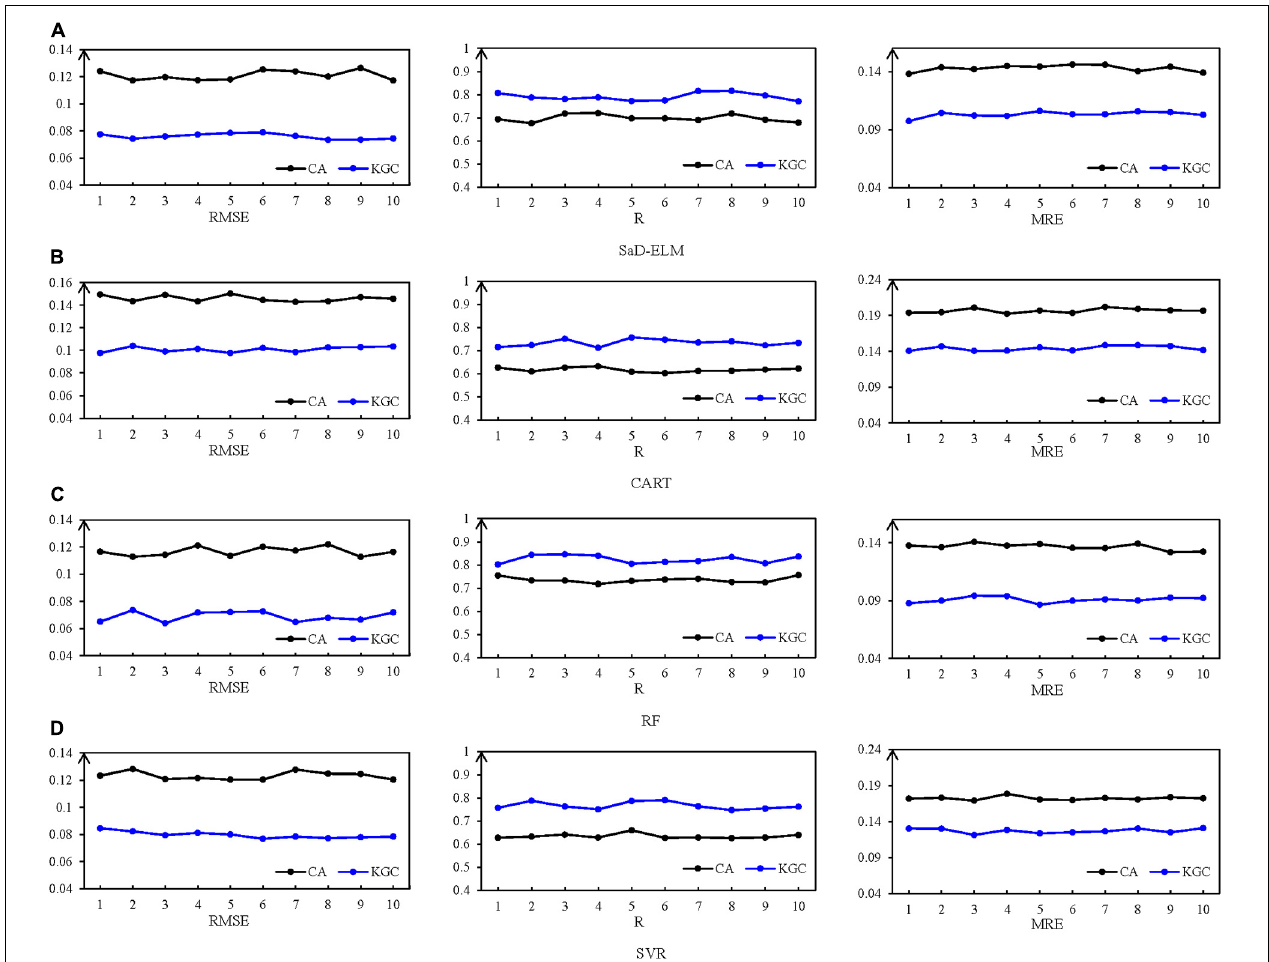
FIGURE 3 | RMSE, R, and MRE of the four prediction model with the 10-fold cross-validation. (A) SaD-ELM. (B) CART. (C) RF. (D) SVR.